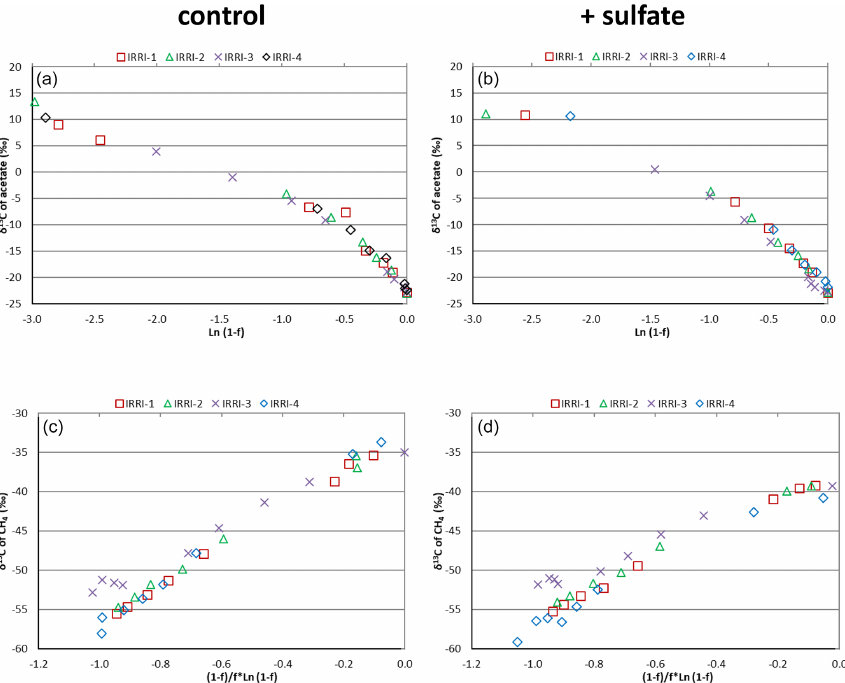
Figure 2. Mariotti plots of (a, b) acetate consumption and (c, d) CH 4 production in (a, c) the absence (control) and (b, d) the presence of gypsum (and sulfate) in four replicates of unbuffered suspensions of paddy soil from the IRRI.